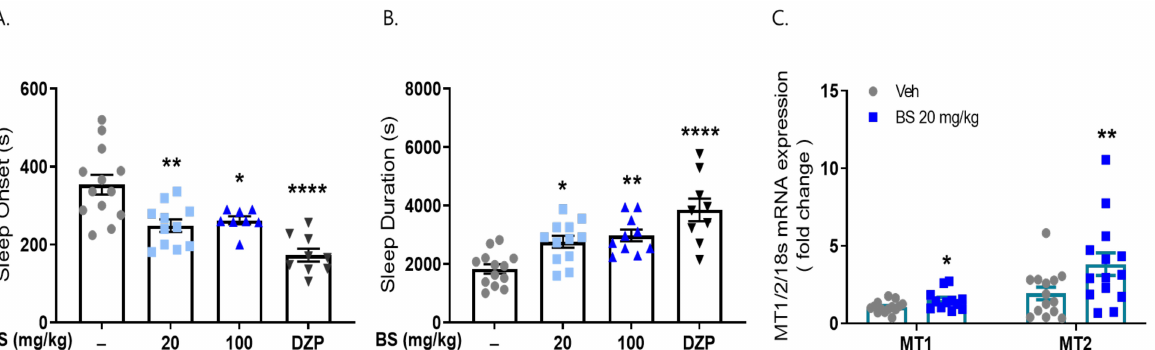
Figure 7. Effects of β -sitosterol on pentobarbital-induced sleep animal model. Mice were adminis- tered β -sitosterol (BS, 20, 100 mg/kg) and positive control (diazepam, DZP, 2 mg/kg) for 7 days orally. Sleeping test was performed on day 8. ( A ) Sleep latency (s), ( B ) sleep duration (s). After sleeping test, frontal cortex was dissected, and qRT-PCR was performed for MT1/2 mRNA expression. ( C ) MT1/2 mRNA expression. * p < 0.05, ** p < 0.01, **** p < 0.0001; Veh vs. BS and DZP (N =